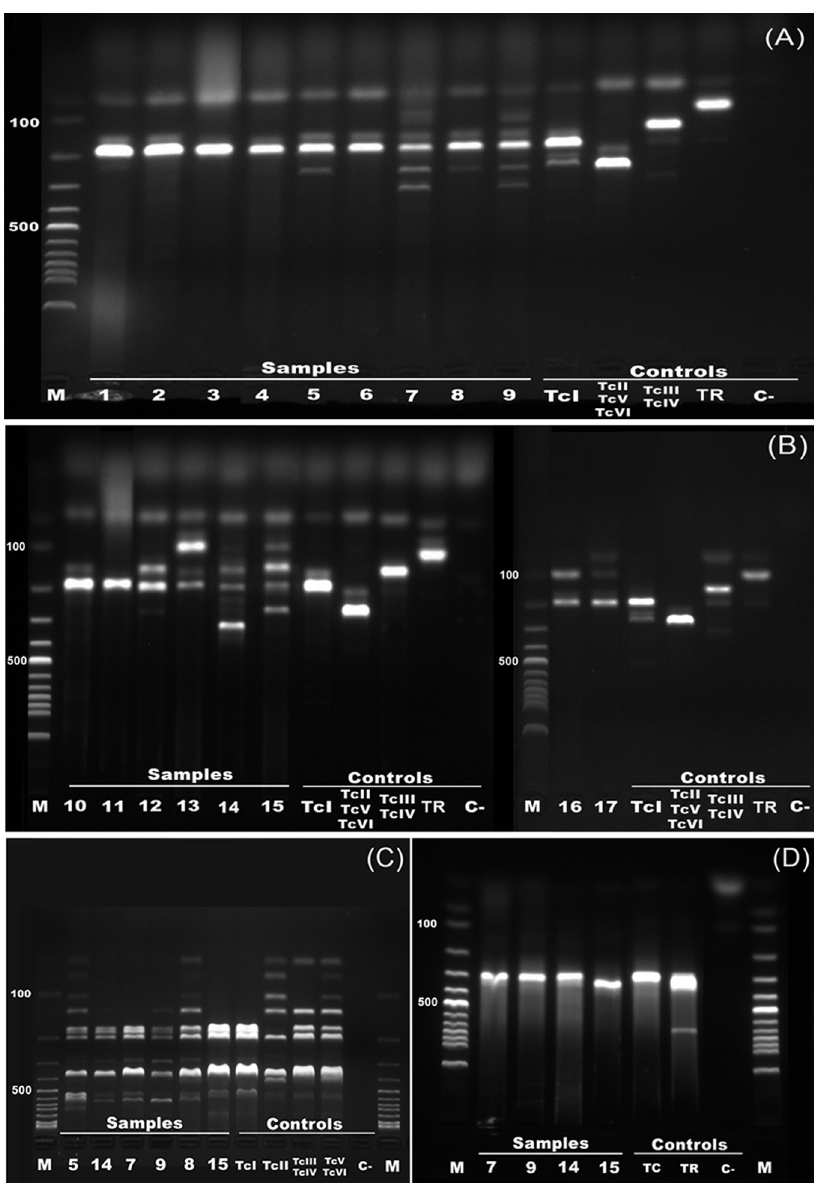
Figure 2. Trypanosoma cruzi genotyping of wild carnivore isolates from the Pantanal wetland, Brazil. Representative agarose electrophoresis gels stained with ethidium bromide of the (A and B) Mini-exon multiplex PCR products, (C) 1f8 gene/Alw21I PCR-RFLP products and (D) kDNA PCR products. Lanes: M. Molecular weight markers (100bp DNA ladder), 1- Procyon cancrivorous isolate; 2–17– Nasua nasua isolates. Control samples: TcI, TcII, TcIII/TcIV, TcV/TcVI, TR - T. rangeli , TC – T. cruzi and C- Negative control.